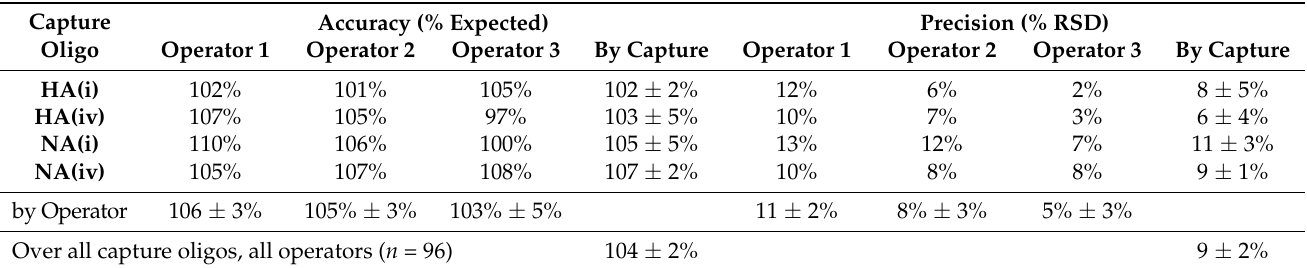
Table 2. Accuracy and